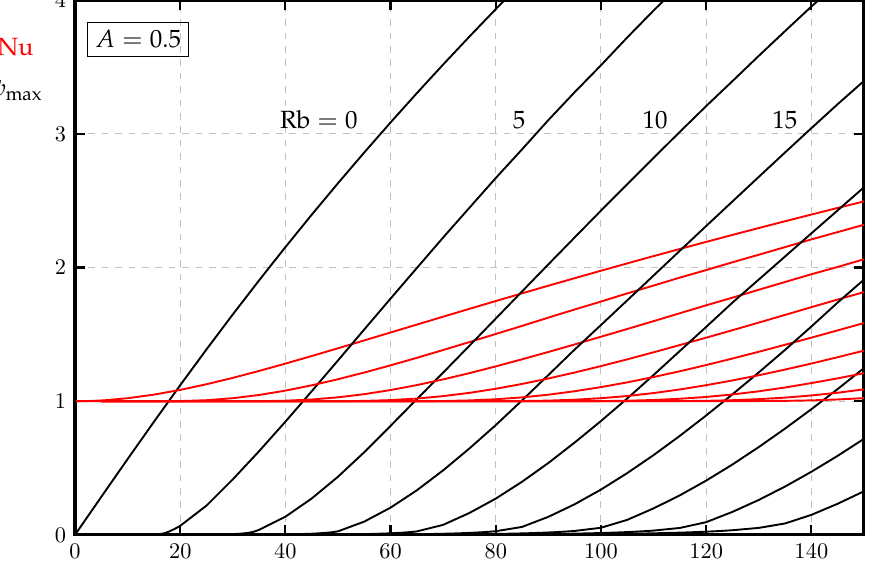
Figure 3. For an aspect ratio, A = 0.5, the variation with Ra of the maximum value of the stream- function, ψ max (black) and the Nusselt number, Nu (red) as Rb increases in steps of 5 from Rb = 0 to Rb = 40. Rb increases towards the right for ψ max and downwards for Nu.